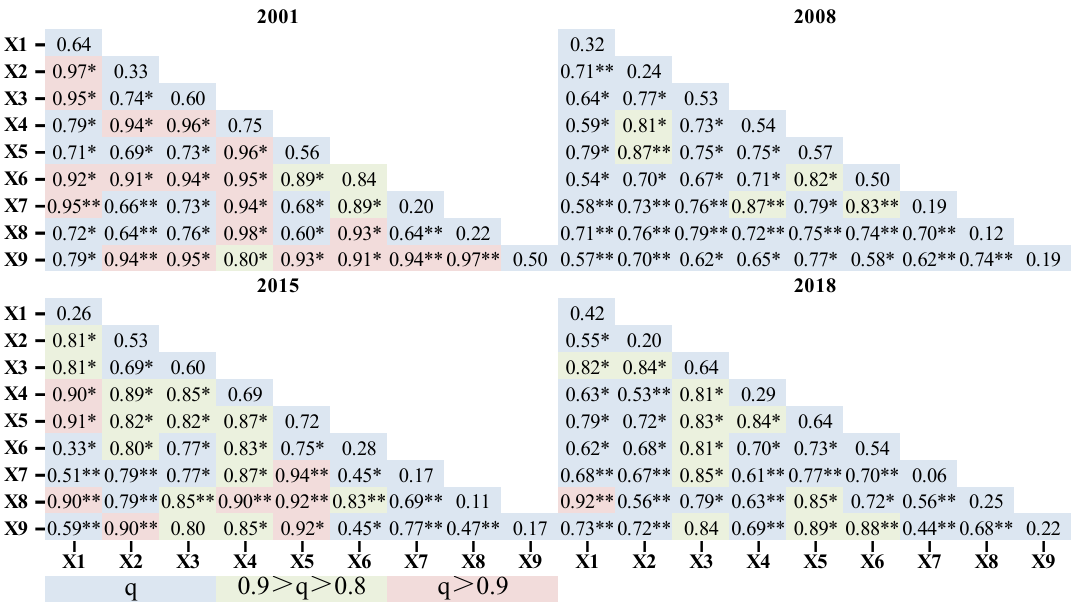
Figure 7. Results of interactions between factors influencing entrepreneurial activities in the Yangtze River Delta. Note: * and ** indicate “Enhance, bi” and “Enhance, nonlinear”, respectively. Per capita GDP (X1), the ratio of the output of tertiary industry (X2), the year-end loan balance of financial institutions per capita (X3), the total ratios of imports and exports to GDP (X4), the total number of postal and telecommunications businesses per capita (X5), total retail sales of consumer goods per capita (X6), the density of the highway network (X7), the ratio of employees at the end of the year (X8), the number of patents granted per 10,000 people (X9).